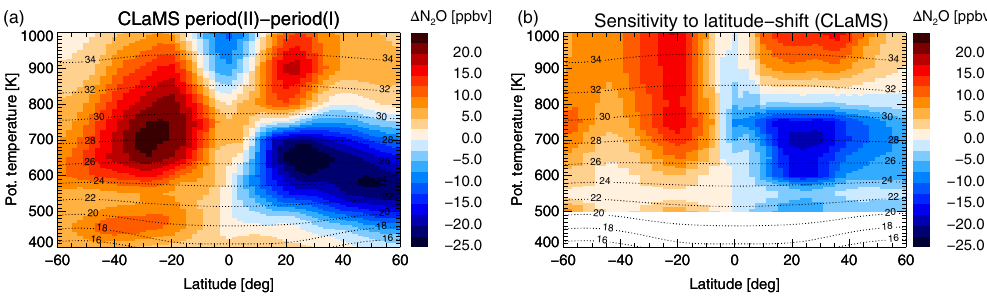
Figure 5. Difference of CLaMS zonal mean N 2 O distributions between the periods I and II (a) , compared to the effect of a shift of the N 2 O zonal mean distribution of period I according to the altitude-dependent latitude shifts of the subtropical transport barriers as derived for CLaMS (Fig. 2f) (b)